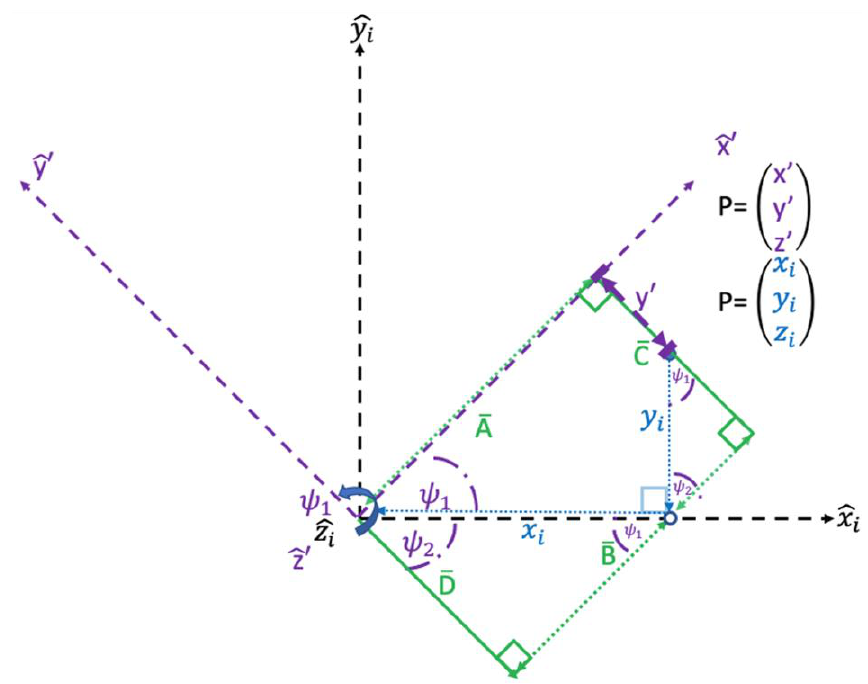
Figure 13. 3-rotation about the 𝑧 𝑖 ̂ and 𝑧′̂ axes using the rectangle 𝐴𝐵𝐶𝐷̅̅̅̅̅̅̅̅ , the corresponding angles 𝜓 𝜓 1 and 2 , and the same similar triangles built-in Figures 7 – 12, except to measure Table 3. Proximal variable and nomenclature definitions for Figures 13 – 15.